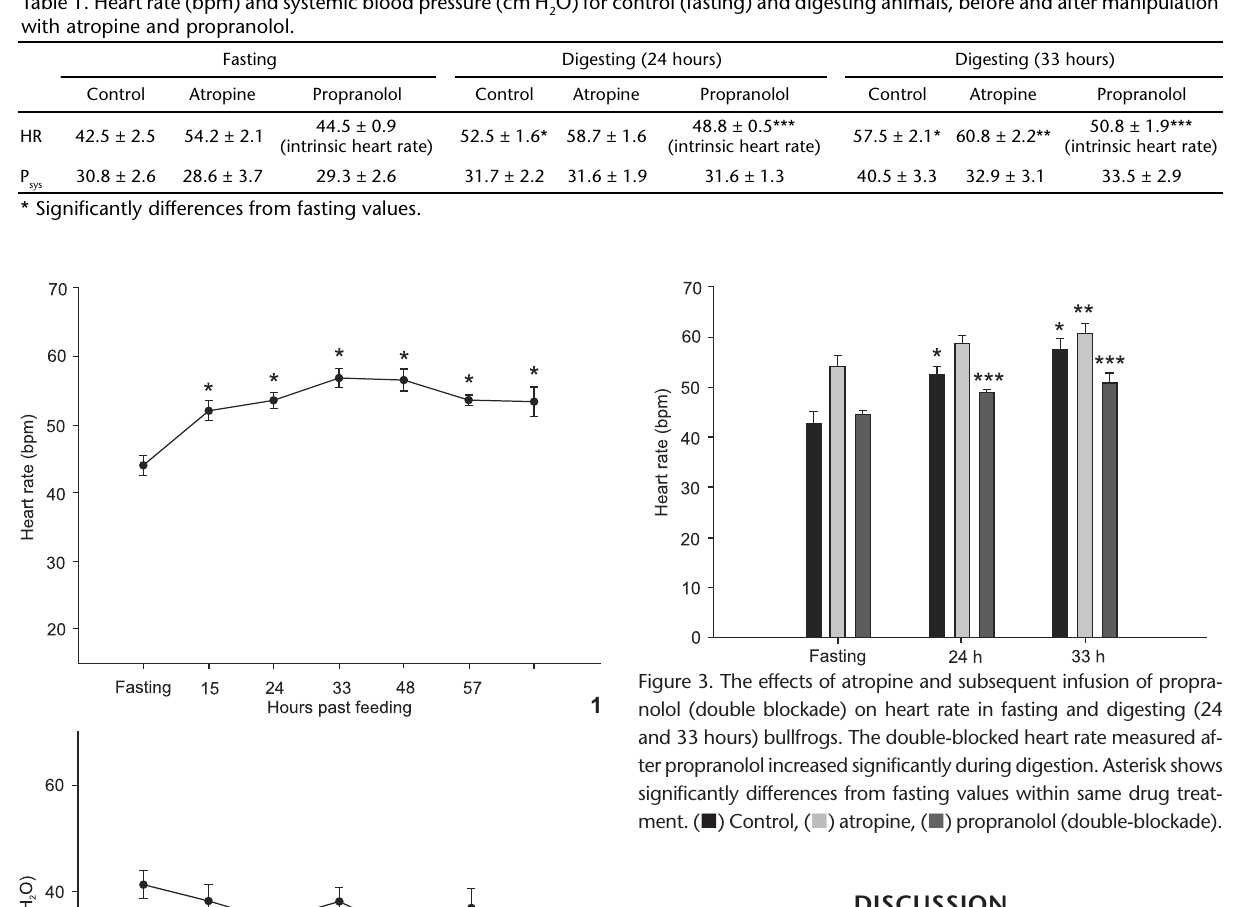
O) for control (fasting) and digesting animals, before and after manipulation 2